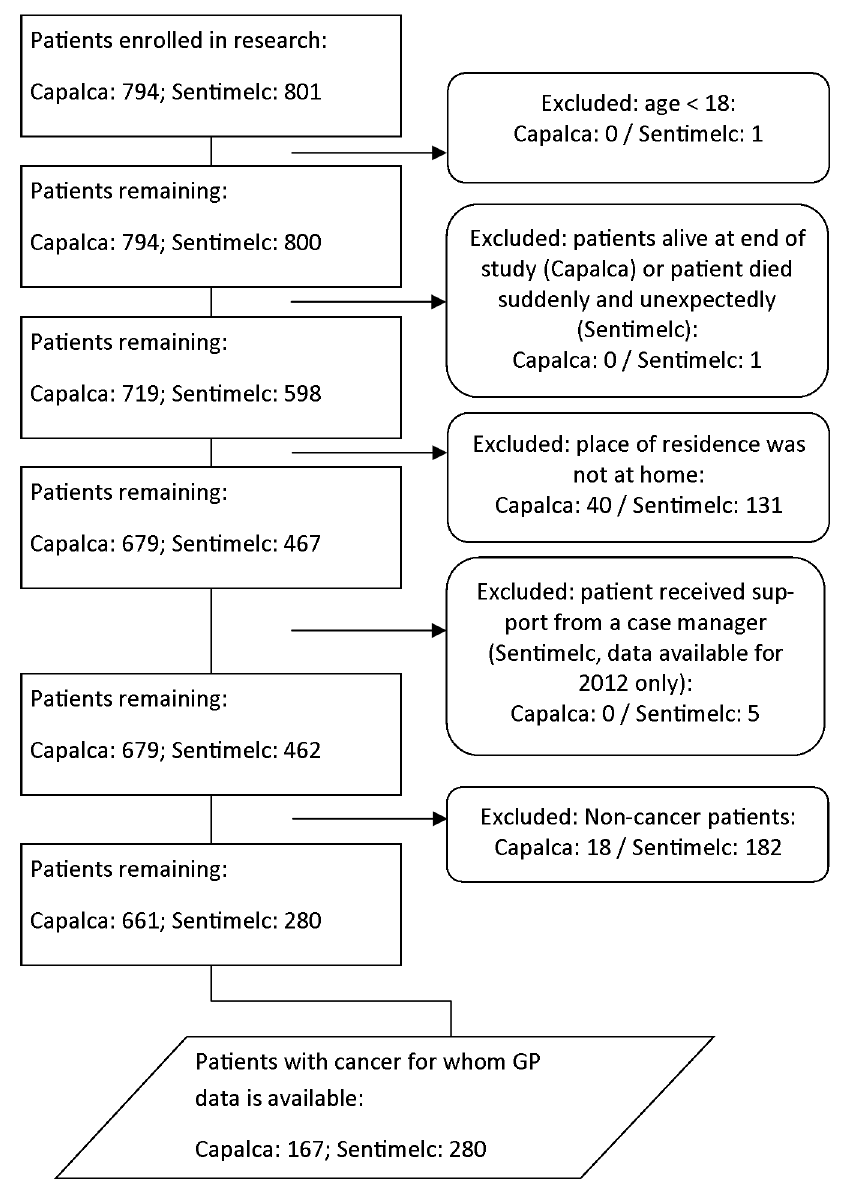
Fig 1. Flow chart of selection † . † Capalca = the study on case managers; Sentimelc = the study on standard GP care; GP = general practitioner.